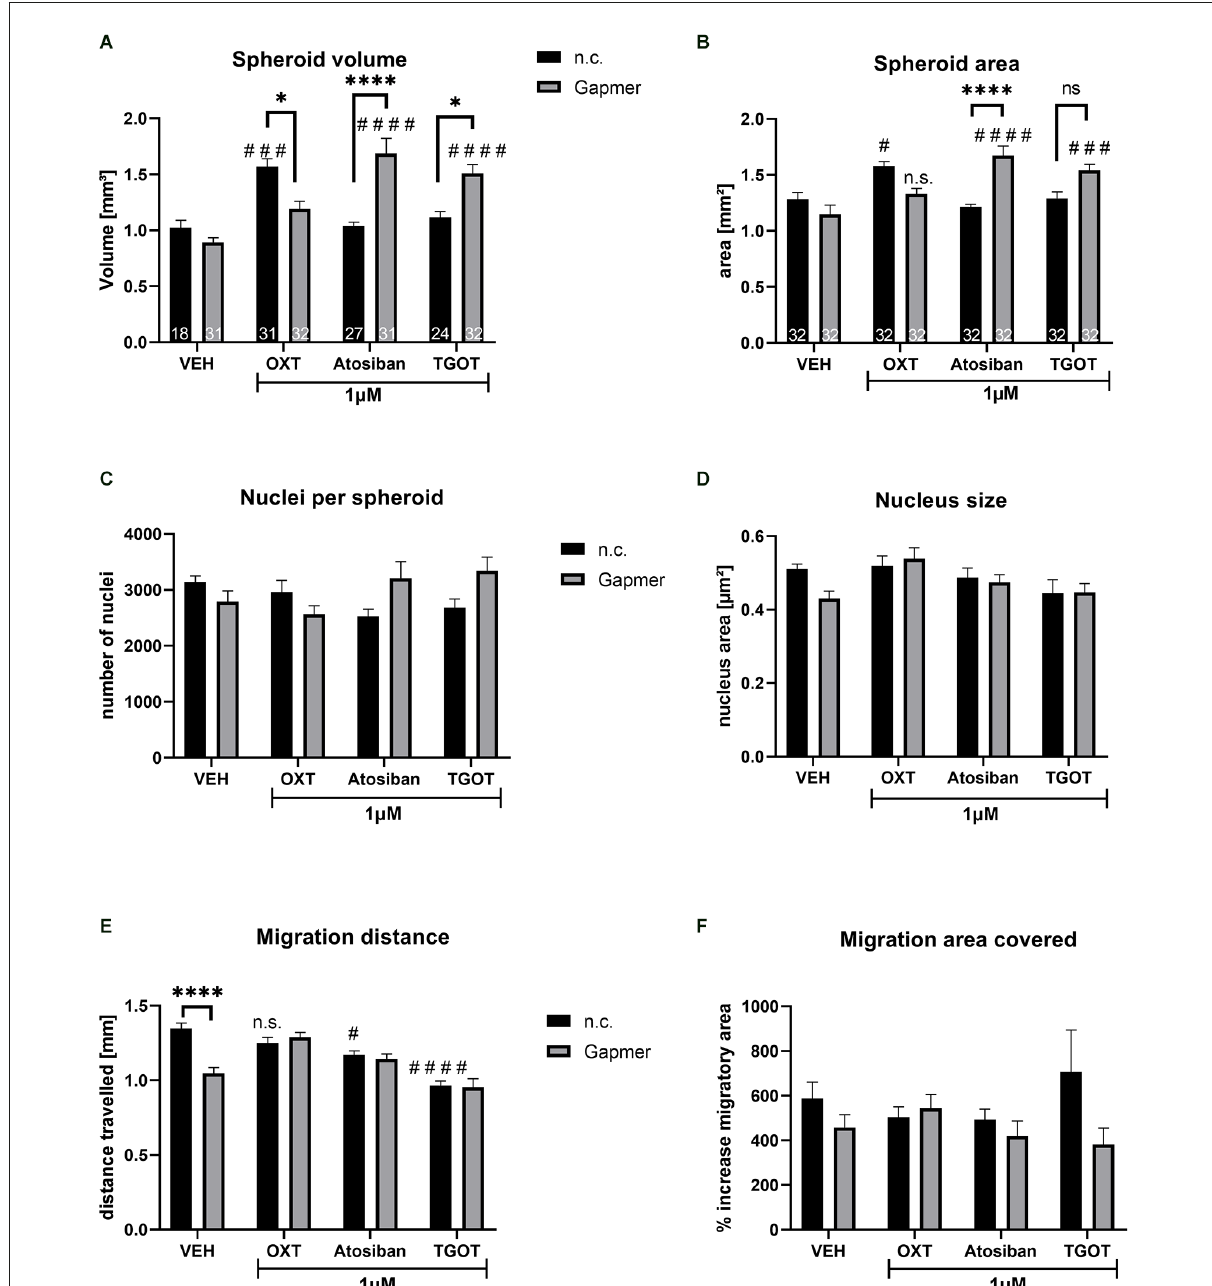
FIGURE3 Spheroid size, nucleus count and size, and cellular migration caused by 1 µ M of ligand treatment (OXT, Atosiban, TGOT) under negative control (n.c.) or OXTR Gapmer (Gapmer) conditions. Legend for all graphs: # = significant vs. the respective VEH control; ∗ = significant vs. respective ligand treatment; n.s. = not significant; data represented as mean + SEM; n.c. = negative control Gapmer; Gapmer = OXTR-specific Gapmers inducing exon 4 skipping. (A) Spheroid volume was not affected by Gapmer pre-treatment under VEH conditions. When stimulated by n.c./OXT, spheroid volume increased significantly compared to n.c./VEH ( p = 0.0005), and Gapmer pre-treatment reversed the spheroid volume back to basal levels ( p = 0.0108). n.c./Atosiban treatment did not alter spheroid volume, but Gapmer pre-treatment increased it 1.68-fold ( p < 0.0001) compared to n.c./Atosiban and Gapmer/VEH. The treatment of n.c./TGOT did not affect spheroid volume, but pre-treatment with Gapmers significantly increased it compared to Gapmer/VEH ( p < 0.0001) and n.c./TGOT ( p = 0.0161). Two-way ANOVA, Gapmer × ligand treatment, significant interaction F (3,218) = 18.10, p < 0.0001; n = 18–27 as indicated in bars. (B) Spheroid area data parallels spheroid volume, with no effect of Gapmer pre-treatment under VEH conditions, but increased spheroid area by n.c./OXT stimulation ( p = 0.0150) compared to n.c./VEH. Gapmer pre-treatment reversed the effect so that the spheroid area is no longer significantly different from the Gapmer/VEH. However, unlike